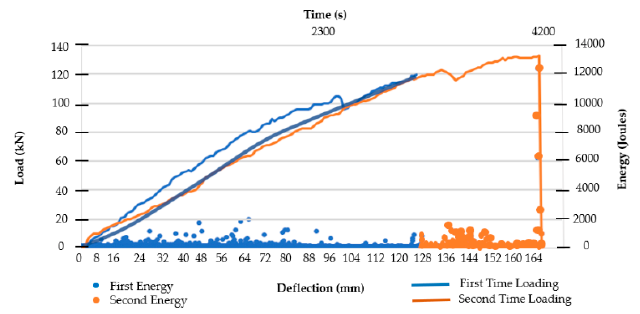
Figure 7. Load–deflection against AE energy under single load test.